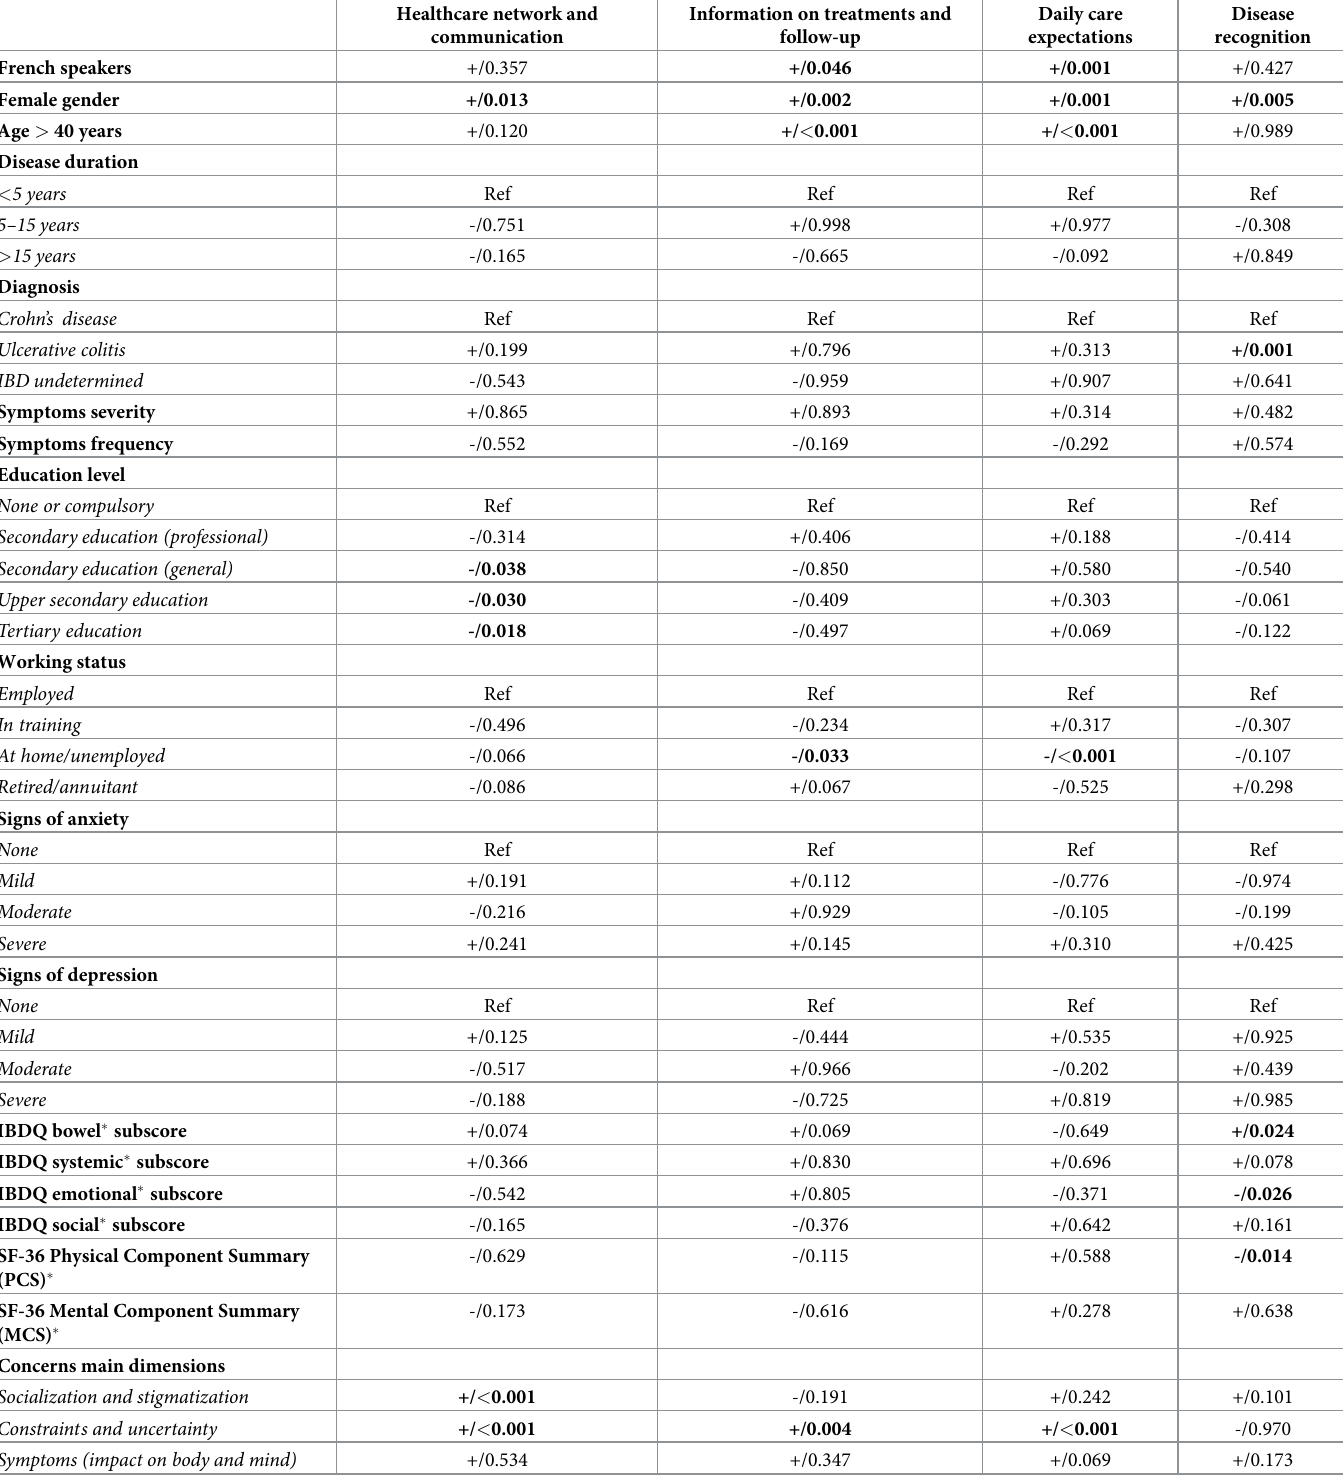
Table 3. Results of multivariate regressions for each expectation dimension performed on data from the SIBDC patient survey. Values indicate the sign of the coeffi- cient (direction of the association) and the p-value. Bold indicates significant